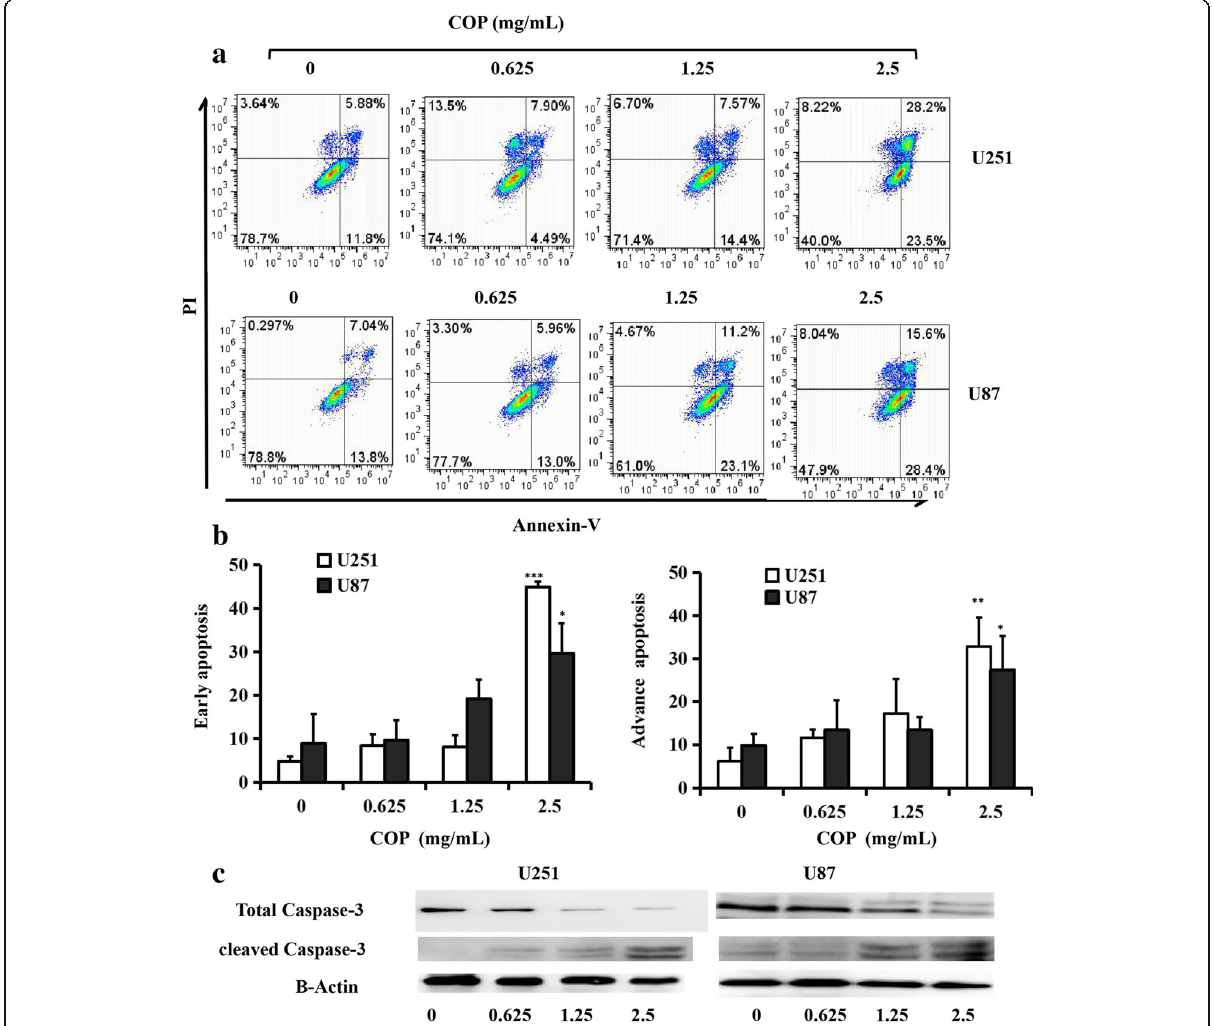
Fig. 7 Effect of COP on cell apoptosis. a U251 and U87 cells were treated with COP at different concentrations (0, 0.625, 1.25 and 2.5 mg/ml) for 24 h, then stained with Annexin V-fluorescein isothiocyanate (FITC)/PI. b Quantitative analysis of dose-dependent alteration of COP on apoptosis. c U251 and U87 cells were treated with COP at different for 24 h, the expression of Caspase 3 were down-regulated and cleaved Caspase 3 were increased. Data are presented as mean ± SD from three independent experiments. *, P < 0.05; **, P < 0.01; ***, P < 0.001 compared with